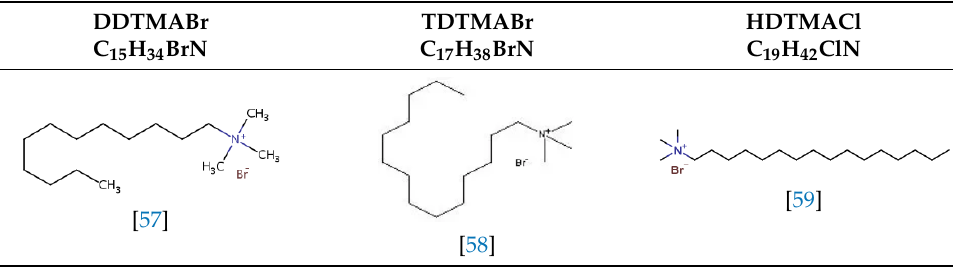
Table 3. Structure of extractants with nitrogen heteroatom.